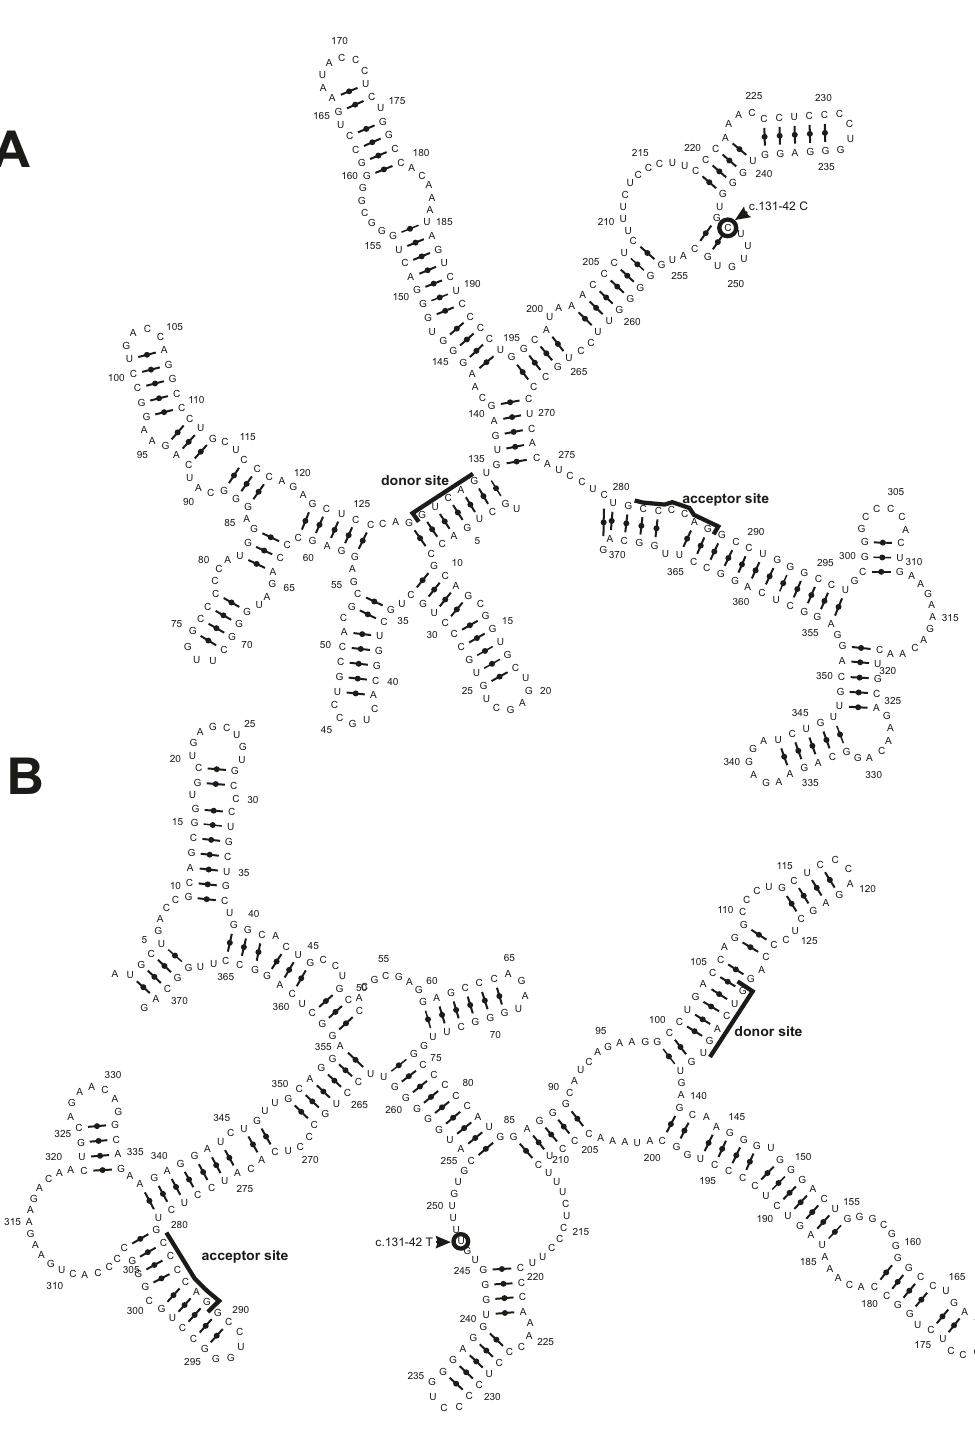
Figure 1 Secondary RNA structure model of AGRP gene fragments containing either C (A) or T (B) at position c.131- 42 . Donor and acceptor sites of second AGRP intron are marked with bold line. Nucleotide positions corresponding to rs1157892 are circled. Modeling was done using Mfold program from Vienna RNA package